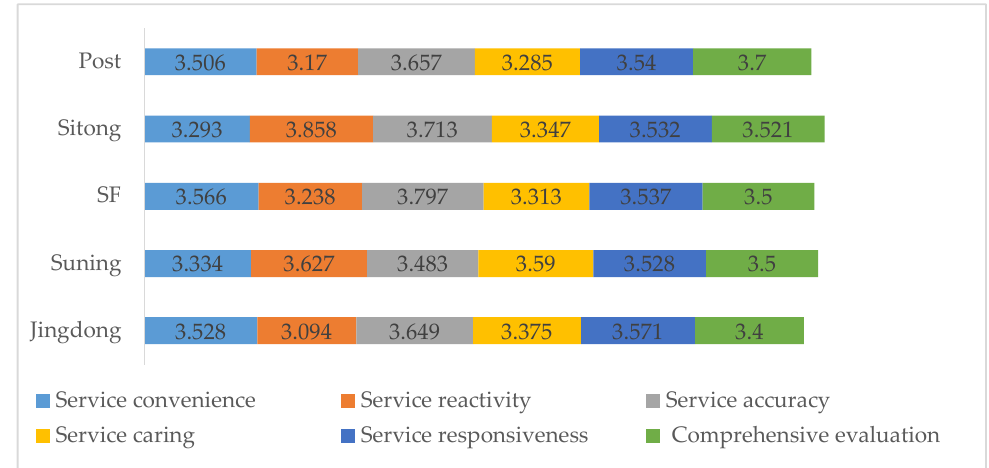
Figure 4. Service quality evaluation results of five logistics companies.